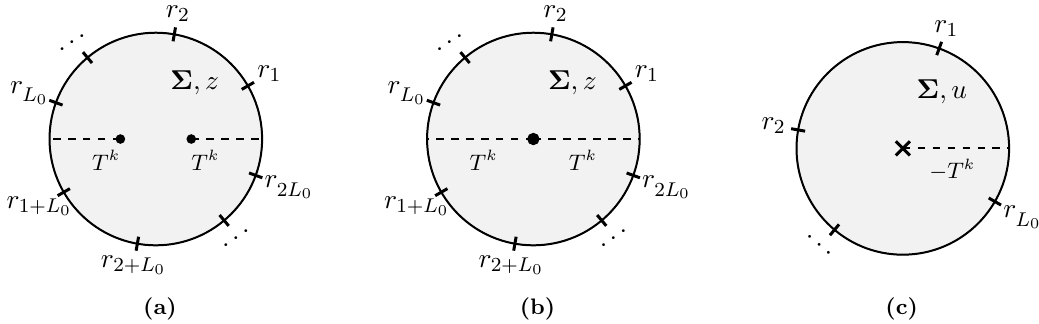
Figure 1. On the left a supergravity solution with two punctures and an even number of poles such that a rotation by (cid:25) combined with an SL(2 ; Z ) transformation by (cid:0) 1 2 maps the solution to itself. In the center the limit where the punctures become coincident. Taking a quotient by the combined rotation and SL(2 ; Z ) transformation that is a symmetry of the solution leads to the solution illustrated on the right. The two branch cuts are identi(cid:12)ed and the combined monodromy becomes (cid:0) T k